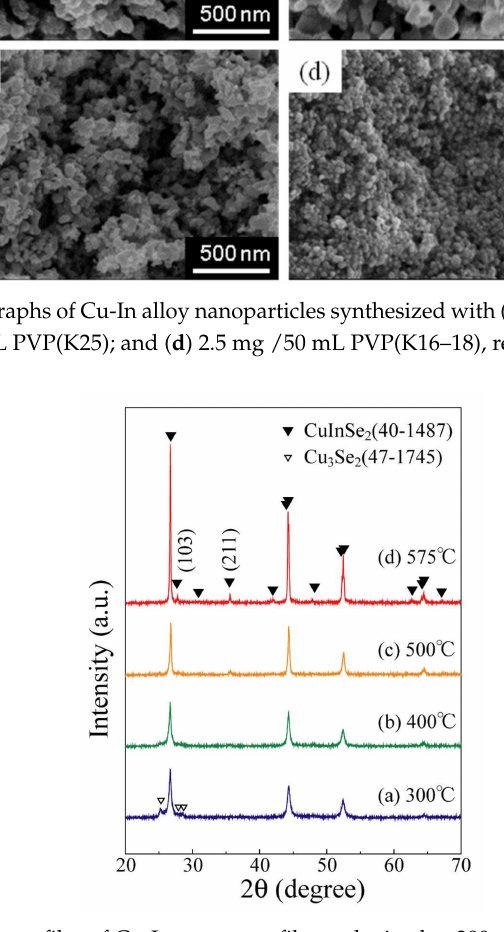
Figure 5. XRD profiles of Cu-In precursor films selenized at 300, 400, 500, and 575 ◦